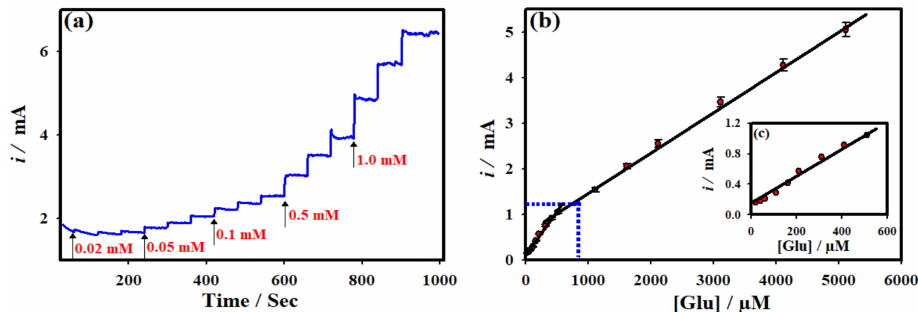
Figure 3. ( a ) CA i-t curve of NC-NiS@NS-NiS|NF sensing electrode measured in 1.0 M KOH with several of glucose concentrations (20.0 µ M–5.0 mM) at the constant applied potential 0.50 V. ( b ) The corresponding calibration plot. ( c ). Expanded view of the calibration plot of Figure 3b.